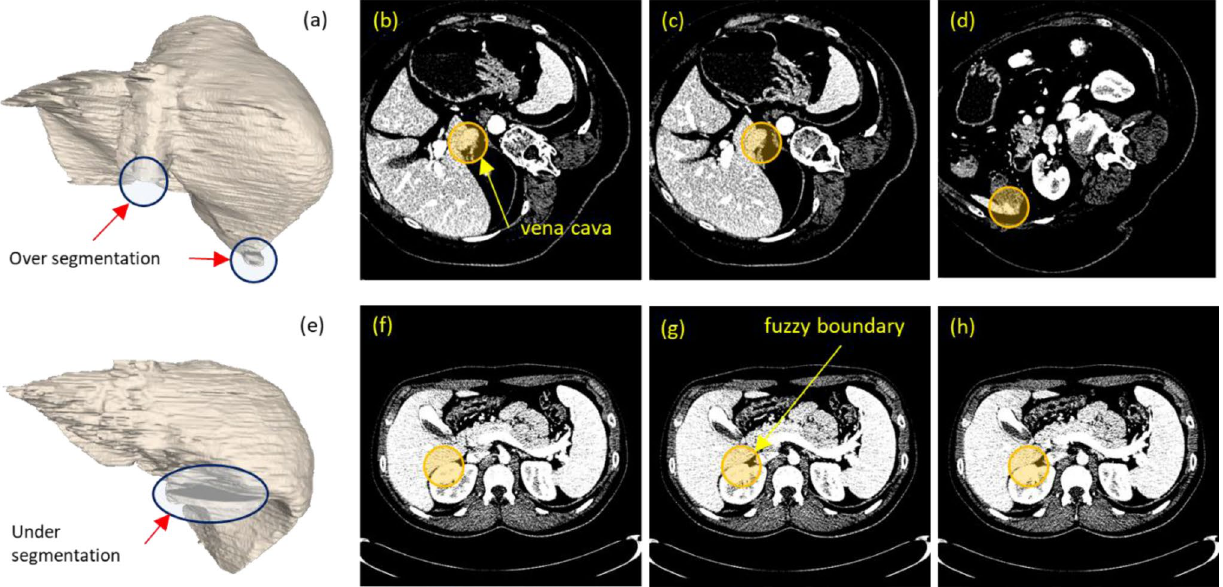
Figure 8. Examples of 3D segmentations ( a ) and ( b ), i.e., case 05 (top row) and 09 (bottom row), whose scores were the highest and the lowest, respectively. The corresponding images on their right shows CT slices where over ( b ), ( c ), and ( d ) and under ( f ), ( g ), and ( h ) segmentation occurred.